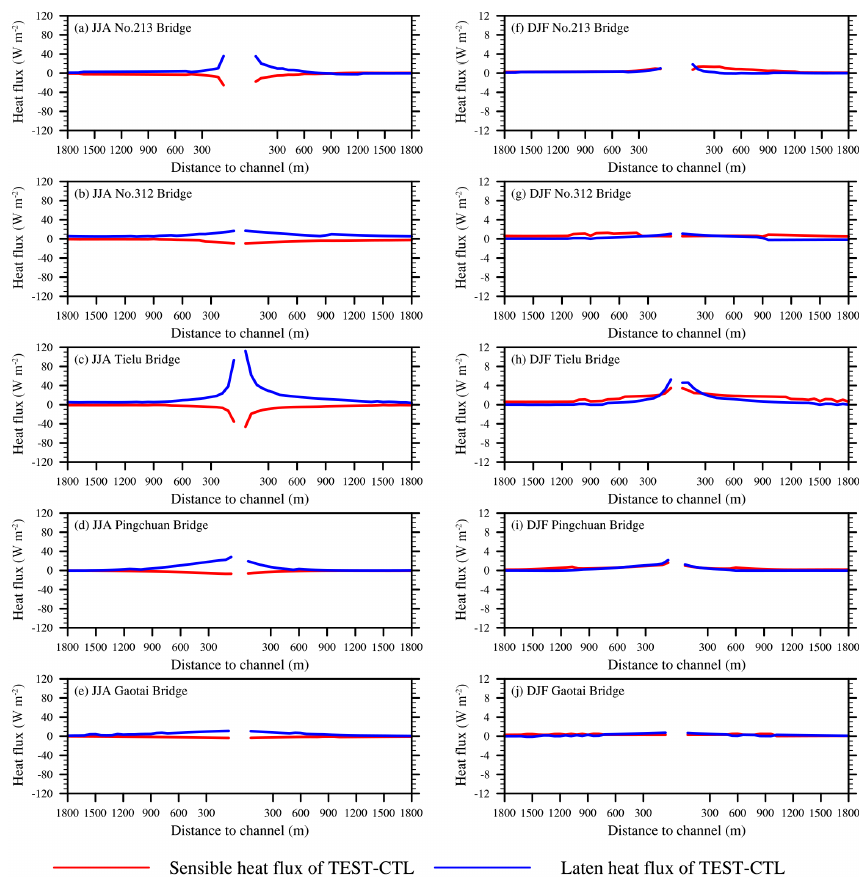
Figure 17. Differences of (a–e) sensible and (f–j) latent heat fluxes predicted by TEST and CTL simulations along the five sections at (a, f) 213 Bridge, (b, g) 312 Bridge, (c, h) Tielu Bridge, (d, i) Pingchuan Bridge, and (e, j) Gaotai Bridge. The discontinuous parts of the curves represent the river